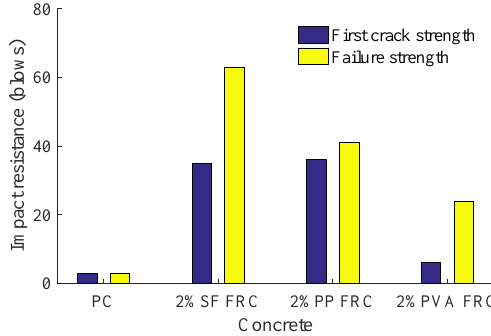
Figure 7. Fiber reinforcement effect on drop impact